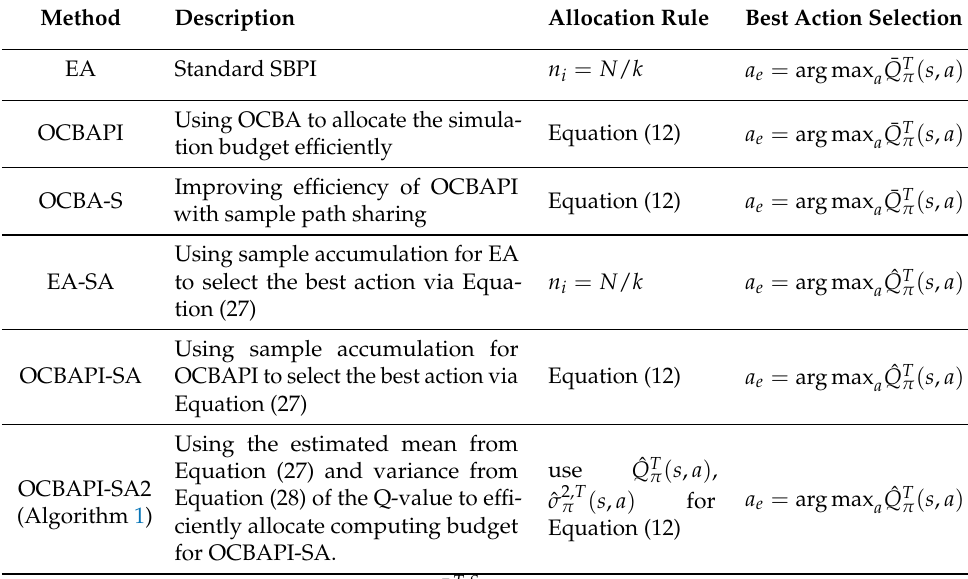
Table 1. Summary of comparison